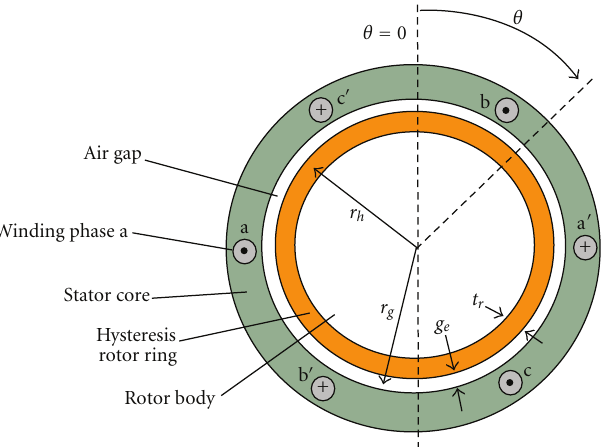
F 1: A cross-section of a circumferential-�ux hysteresis motor.